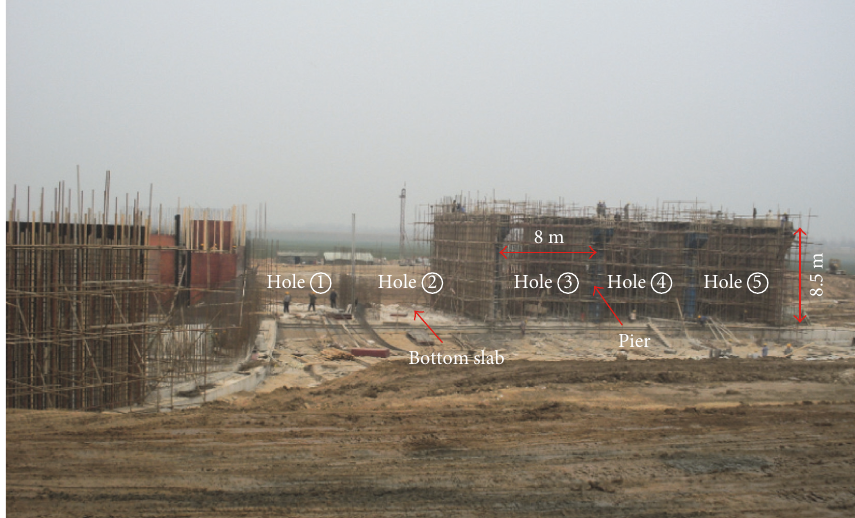
Figure 2: A sluice project in the construction period at Huaihe River in China.